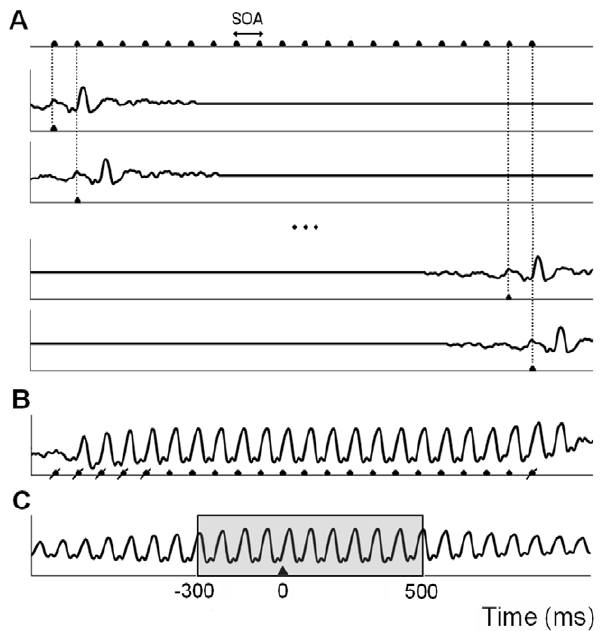
Figure 2. Procedure to synthesize steady-state responses. Synthetic data for each subject and stimulation rate were obtained by linear addition of the corresponding transient response template. A , The template was time-shifted at its corresponding SOA to create 22 synthetic trials. Here, we show as an example the transient template for the 12.5 rev/s condition of Experiment 1, time-shifted every 80 ms. B , The first five trials and the last one were discarded as for the recorded data. The remaining 16 synthetic trials were linearly added to simulate the response to one stimulation sequence. The triangles indicate stimulus onset. C , The synthetic signal was segmented into stimulus- locked epochs that were averaged. The epoch lasting from 300 ms pre- stimulus to 500 ms post-stimulus was extracted to be compared with its corresponding recorded waveform.